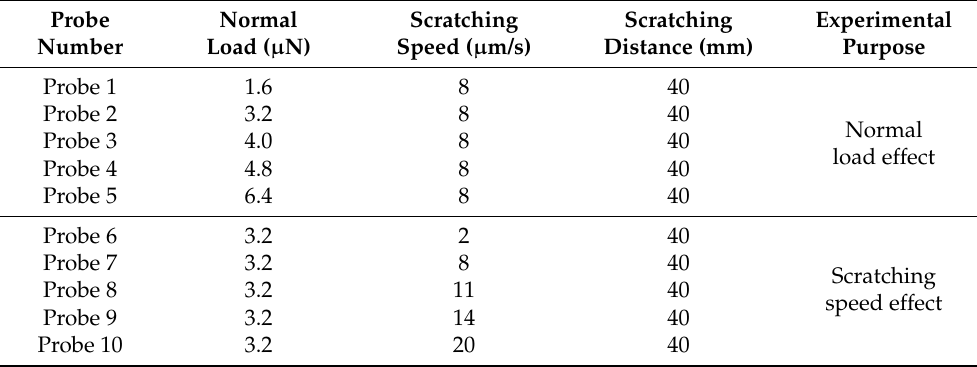
Table 1. Nanomachining parameter setting in the experiment .